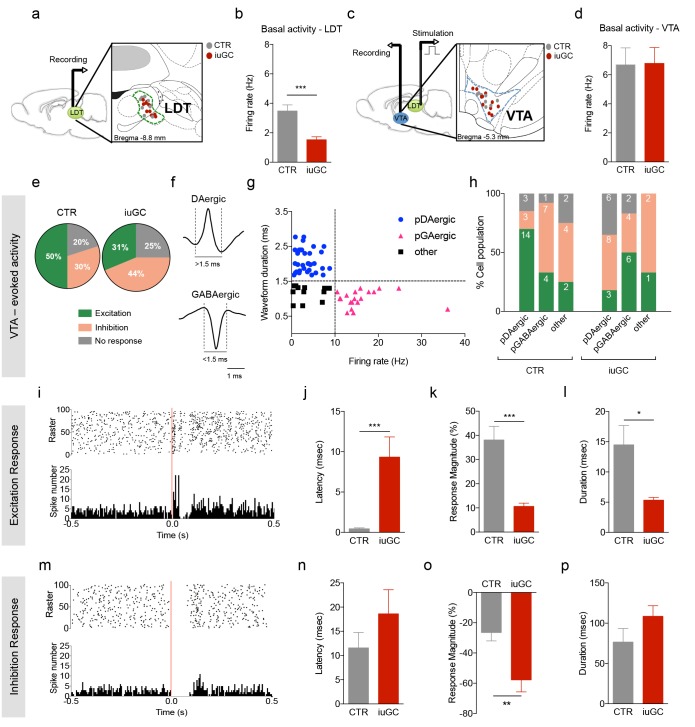
Distinct VTA neuronal response to LDT electrical stimulation in iuGC animals.(a) Schematic representation of the in vivo single-cell electrophysiological recording experiments and electrode placement in the LDT in anesthetized animals. (b) iuGC animals present decreased basal activity of LDT neurons in comparison to CTR (nLDT-CTR = 36 cells; nLDT-iuGC = 94 cells). (c) Schematic representation of the in vivo single-cell electrophysiological recording experiments in the VTA with electric stimulation performed in the LDT; and recording electrode placement. (d) The basal activity of the VTA is similar between groups (nVTA-CTR = 40 cells; nVTA-iuGC=32 cells). (e) Electrical stimulation of the LDT (0.5 Hz) induces excitatory and inhibitory responses in VTA neurons. Pie plots represent the percentage of excitatory, inhibitory and no responses of VTA neurons. (e–g) In CTR animals, 50% of neurons present an excitatory response (70% pDAergic, 20% pGABAergic) and 30% present an inhibitory response (21% pDAergic, 50% pGABAergic). iuGC group shows a different profile, with 31% of recorded cells presenting an excitatory response (30% pDAergic, 60% pGABAergic) versus 44% with inhibitory response (57% pDAergic, 29% pGABAergic). (f) Representative examples of rat VTA pDAergic and pGABAergic neuronal waveforms. (g) Firing rate and waveform duration were used to classify single units into 3 types of neurons. (h) Percentage of each putative neuronal population presenting excitation, inhibition or with no response to LDT stimulation. There is a shift in the percentage of putative DAergic and GABAergic neurons presenting excitatory and inhibitory responses. Numbers in bars represent number of cells in each category. (i, m) Peristimulus time histograms (PSTHs) show LDT-evoked responses of VTA dopamine neurons; (i) excitation; (m) inhibition. (j) VTA neurons that display an excitatory profile in response to LDT electrical stimulus present increased latency to fire in iuGC animals. (k) The magnitude and (l) duration of response of VTA neurons is reduced in iuGC animals. (n) VTA neurons that display an inhibitory response in response to LDT electrical stimulus do not show differences in the latency to fire in both groups. (o) The magnitude of response of inhibited neurons of the VTA is increased in iuGC animals, with no differences in (p) the duration of inhibition in VTA neurons upon LDT stimulation. pDAergic: putative dopaminergic neurons; pGABAergic: putative GABAergic neurons. Data is represented as mean ±s.e.m. *p<0.05, **p<0.001, ***p<0.0001.